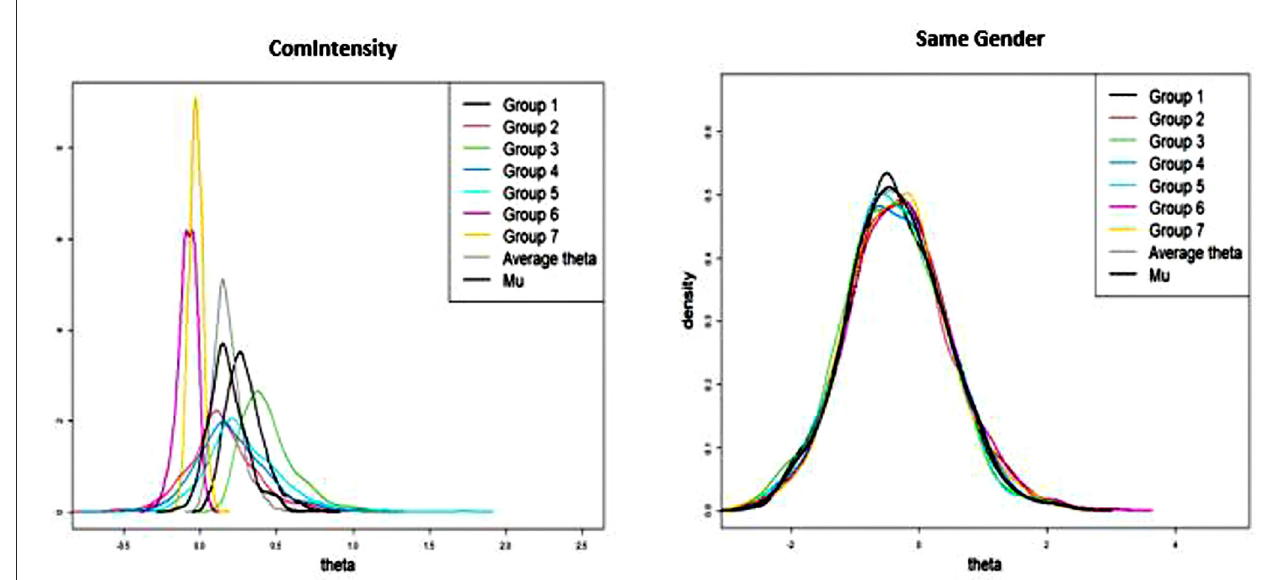
FIGURE3 Density plots for random effects. Theta, estimated coefficient, Mu, Observed